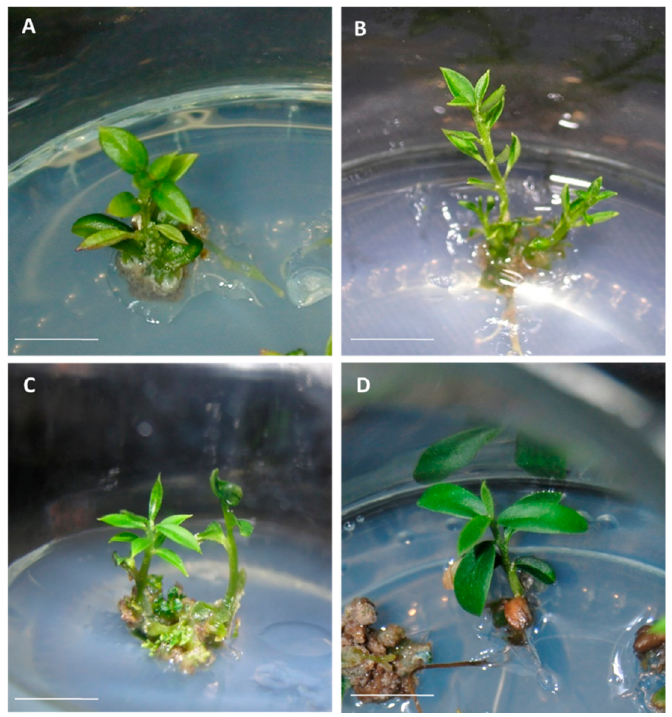
Figure 1. Plantlets regenerated from ( A , C ) control and ( B , D ) cryopreserved embryogenic cultures of the lines T1 ( A and B ) and P5 ( C and D ). Bar = 1 cm.